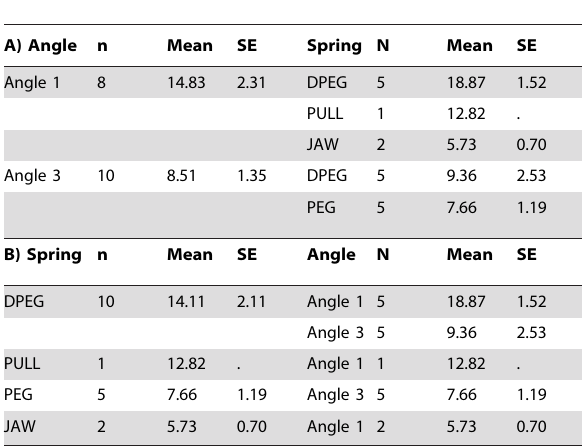
Table 3. Mean values and standard errors of clamping force (N) among rat trap